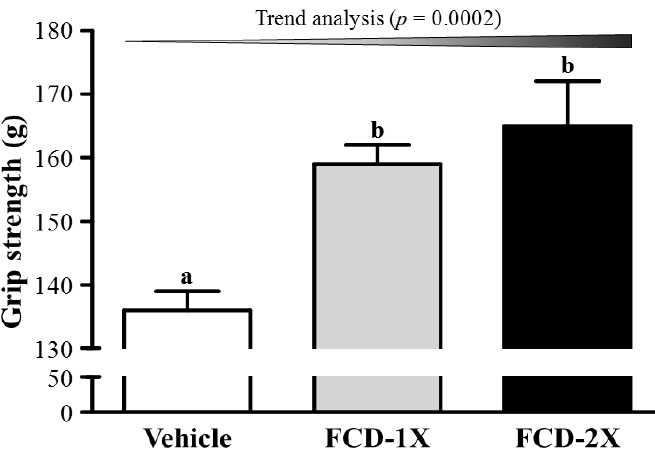
Figure 1. Effect of FCD (Fucoidan) supplementation on forelimb grip strength. Data are